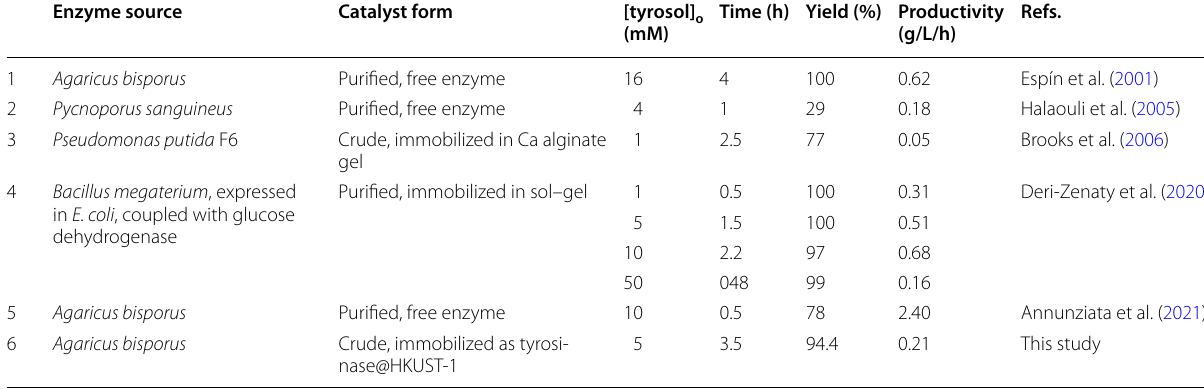
Table 1 Production of hydroxytyrosol from tyrosol catalyzed by tyrosinase, crude or purified, free or immobilized, from different sources Enzyme